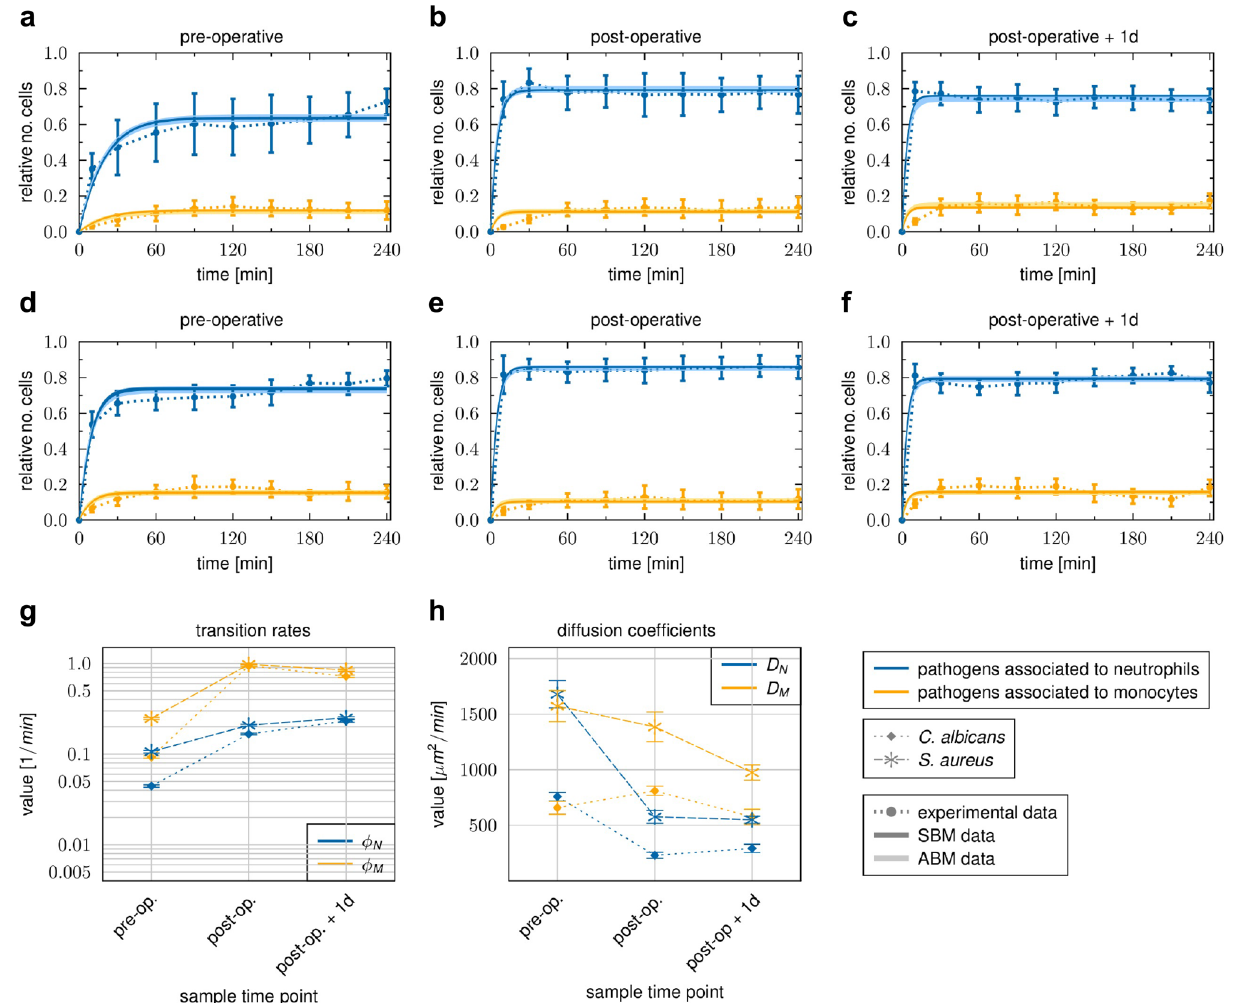
Figure 4. Time courses of pathogen association to immune cells observed in whole-blood samples of HLM patients. Blood samples were taken before cardiac surgery (pre-operative), immediately after surgery (post- operative) and one day after admission to intensive care (post-operative + 1d). Time-resolved experimental data (dotted line) were obtained by whole-blood infection assays with either C. albicans ( a – c ) or S. aureus ( d – f ). Data points and error bars refer to the means and SD of blood samples from six HLM patients. The simulated dynamics of the combined units (solid line) were obtained by fitting the state-based model (SBM, dark color) and the agent-based model (ABM, light color) to the experimental data. The thickness of the results from the SBM represents the SD obtained by 50 simulations with transition rate values that were sampled within their corresponding SD. The thickness of the results from the ABM represents the SD obtained from 30 stochastic simulations of the ABM with the estimated diffusion coefficients. ( g ) Transition rate values of the SBM resulting from fitting the model to experimental data of either C. albicans or S. aureus infection in blood samples from HLM patients. The transition rate values are given for the phagocytosis rate φ N of neutrophils and the phagocytosis rate φ M of monocytes. ( h ) The diffusion coefficients are given for neutrophils D N and monocytes D M . Mean and SD are calculated from all parameter sets with a mean LSE that lies within the SD of the optimal parameter